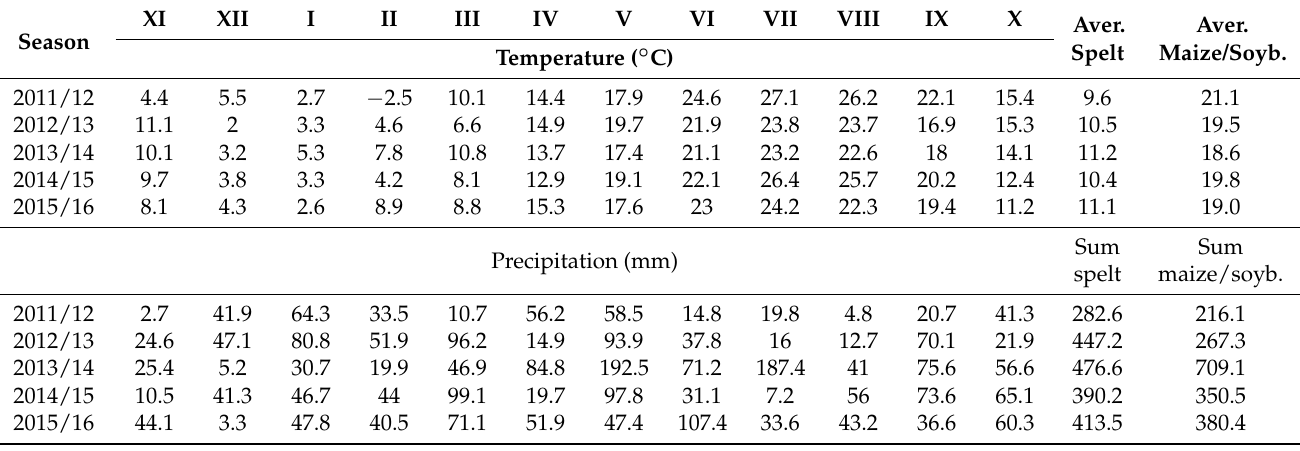
Table 2. Mean temperature ( ◦ C) and precipitation sum (mm) at Zemun Polje during the